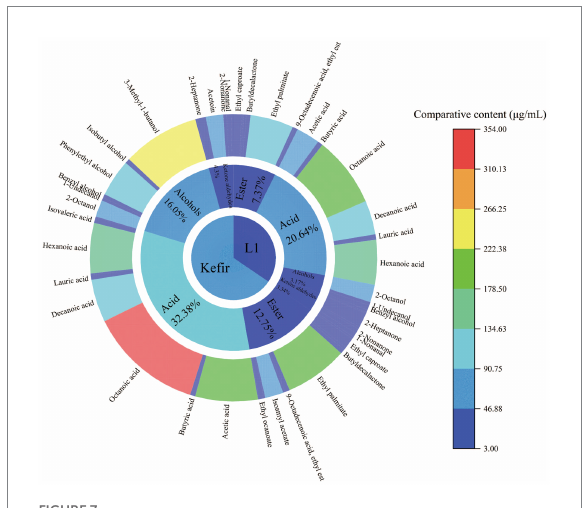
FIGURE 7 Sunburst diagram of flavor substances of L 1 and